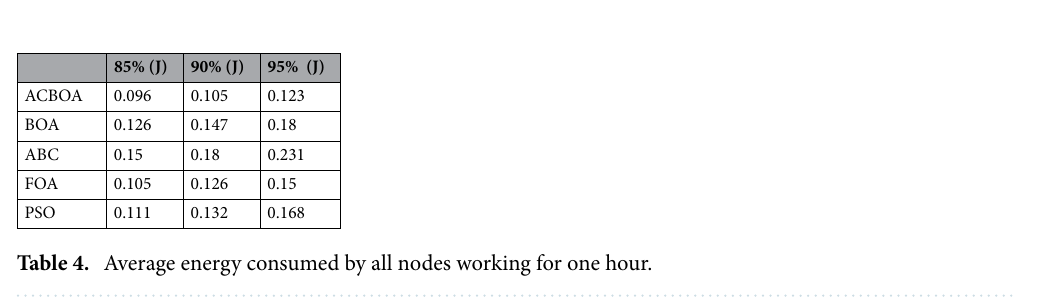
Figure 9. Number of nodes required to reach a defined coverage.